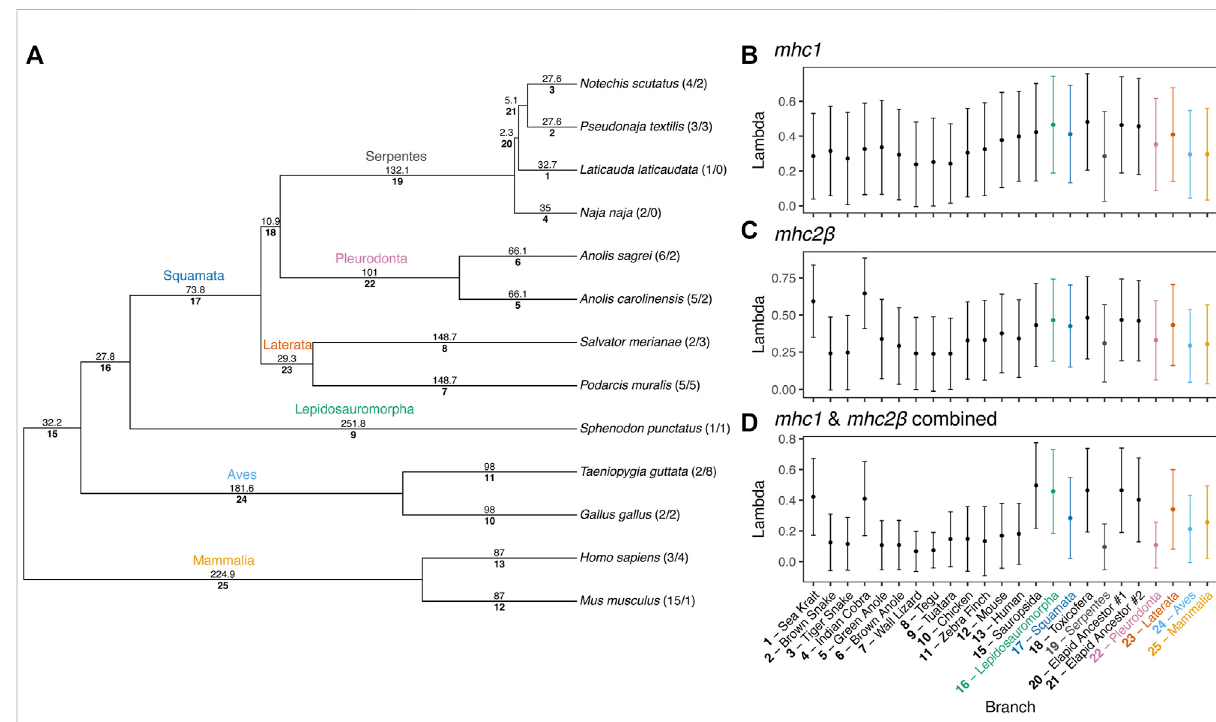
FIGURE 9 Results of a Bayesian analyses of gene family evolution of MHC gene families across 13 amniote species. (A) Guide phylogeny used to analyze gene family evolution. Numbers above each branch indicate time in millions of years, as determined from Timetree.org (Hedges et al., 2006; Kumar etal.,2017).NumbersbeloweachbranchindicatetheindexnumberofthebranchusedinparsingtheBayesianoutput.Numbersafterthetaxanames at the tips of the phylogeny indicate the number of mhc1 and mhc2 β gene copies per species, respectively. Branch indices are used to indicate the median (point) and standard deviation (error bars) of birth-death rates (lambda, λ ) for each branch in the phylogeny for (B) mhc1 , (C) mhc2 β , and (D) acombineddatasetof mhc1 and mhc2 β .Commonnamesforeachspeciesarealsosuppliedforterminalbranchesandcladenamesareprovided for internal branches.